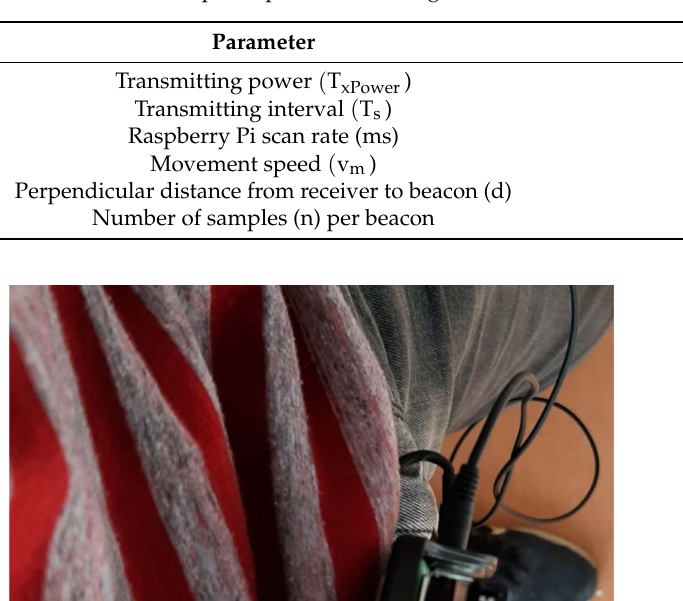
Table 5. Calibration phase parameter settings.